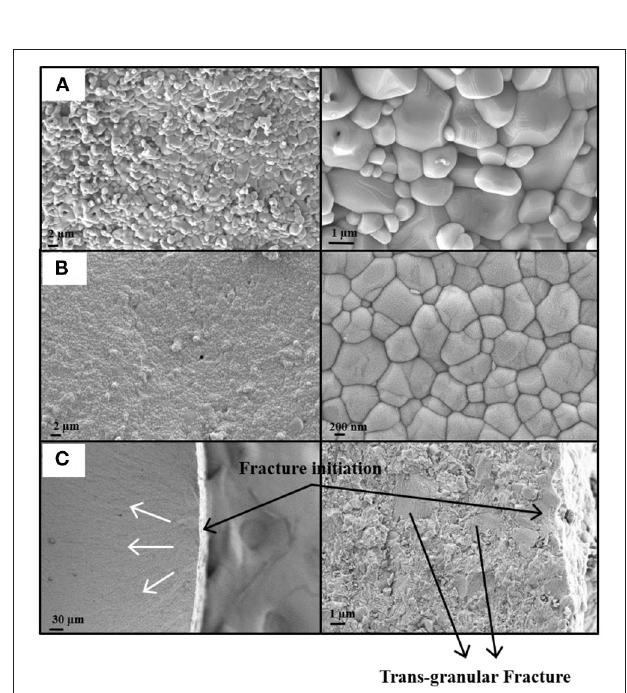
FIGURE 9 | Scanning electron microscopy (SEM) images of sintered surface (A) alumina green machined, (B) 3YSZ green machined, and (C) fractured 3YSZ (crack propagation pattern in white